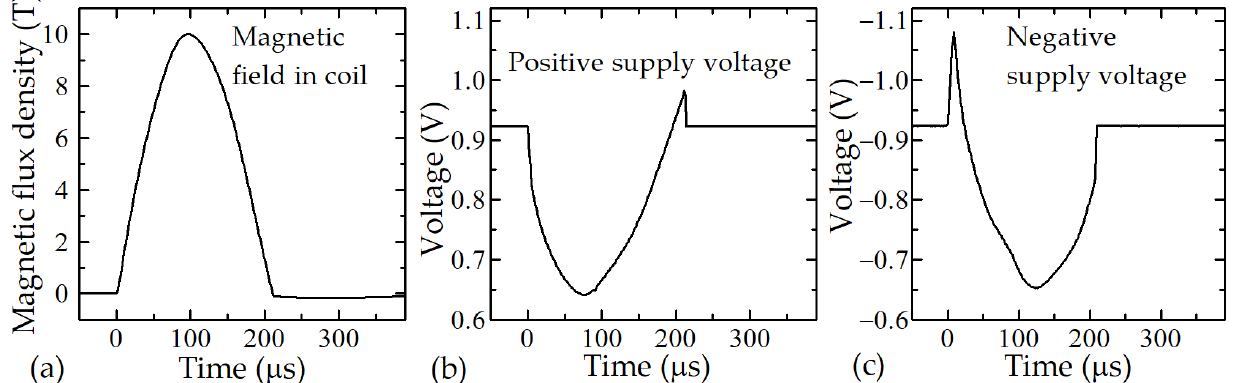
Figure 7. Magnetic field pulse generated in the center of a coil ( a ) and the response of the CMR-B- scalar sensor at positive ( b ) and negative ( c ) polarities of the supply voltage.